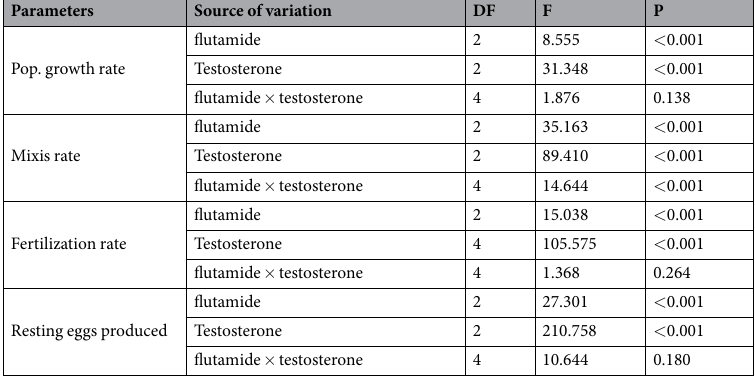
Table 2. Summary of two-way ANOVA on the interaction between flutamide concentration (0, 2.5, 5.0, 7.0 μ g L − 1 ) and testosterone concentration (0, 25, 50, 75 μ g L − 1 ) on population growth rate, mixis rate, fertilization rate, number of resting eggs produced of B. calyciflorus in each tissue (n =